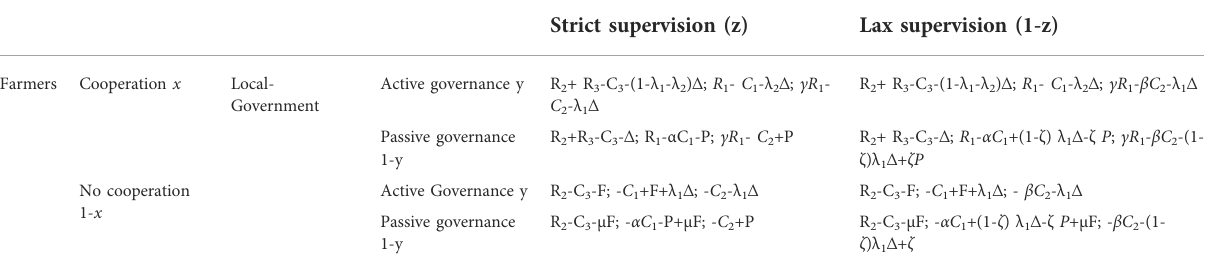
TABLE 2 Revenue matrix. Gaming party Central government